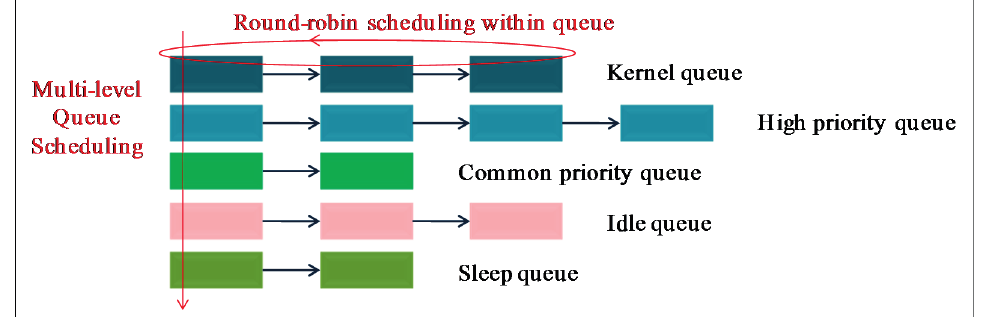
Figure 17. Multi-level round-robin scheduling in mantisOS. By using these scheduling queues, threads in mantis OS can be managed efficiently.